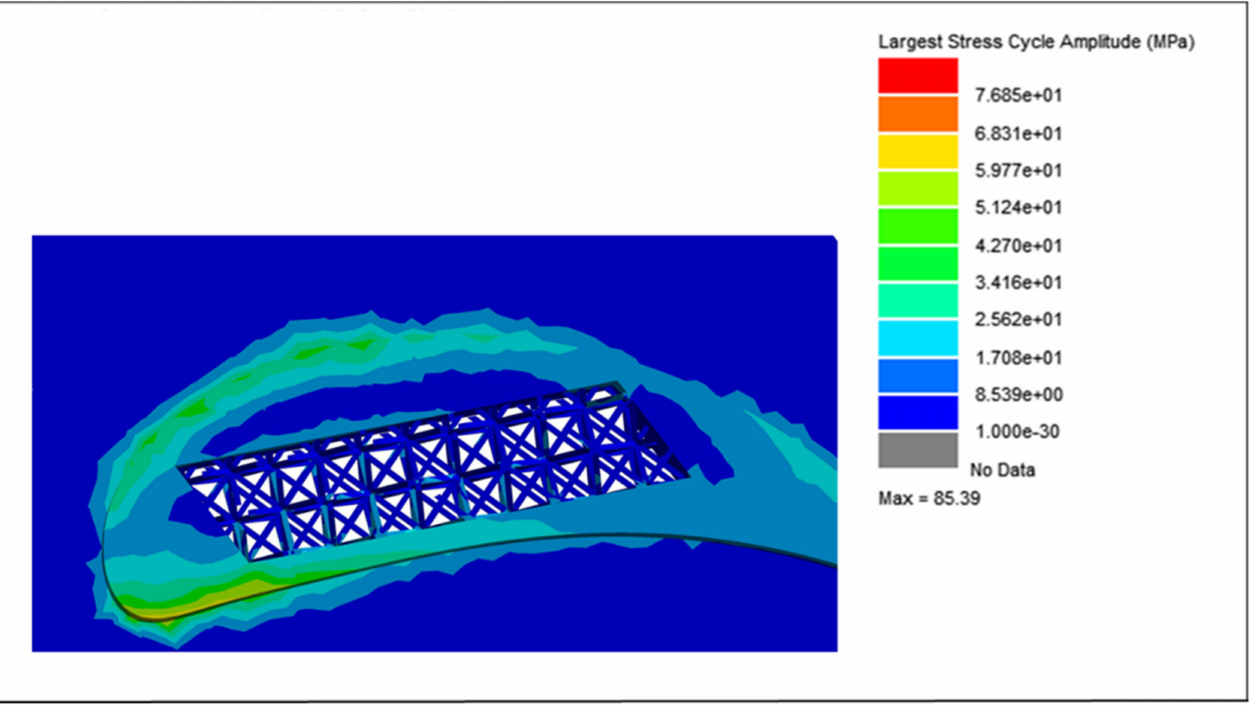
Figure 21. Largest stress cycle amplitude for the 0.25 mm lattice